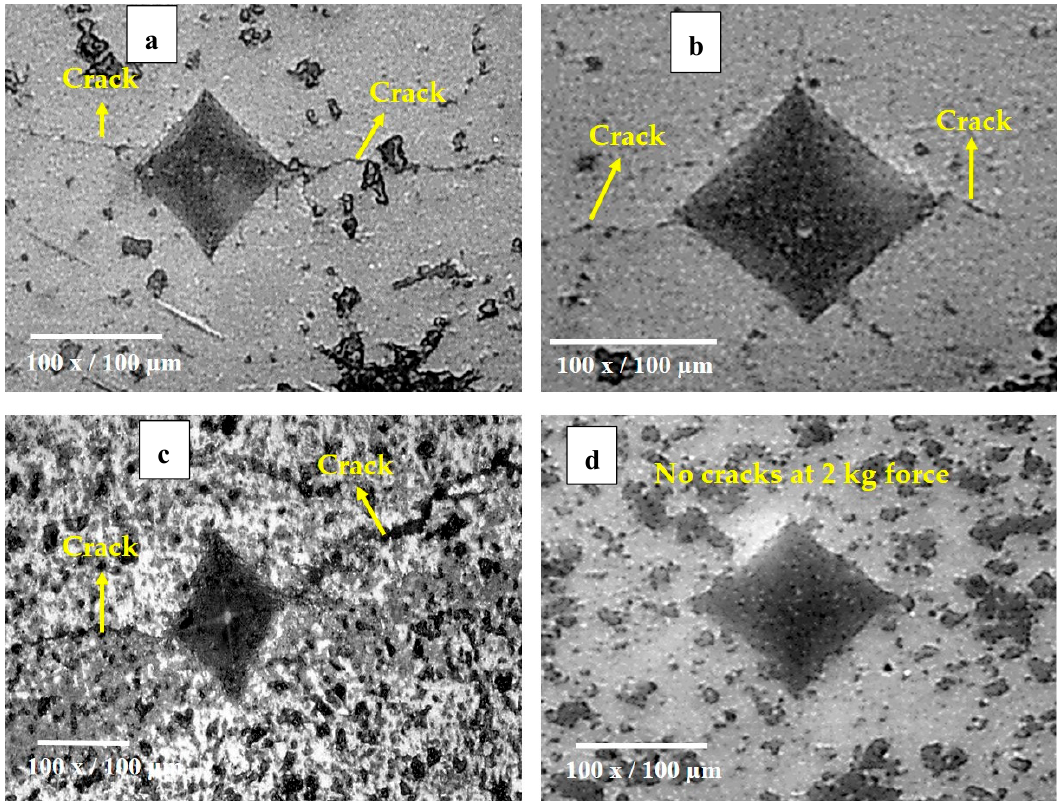
Figure 8. Optical micrographs revealing indentation crack growth in ( a ) As ( b ) AsYs ( c ) Ap and ( d ) ApYs. Table 3. Indentation crack length in the coatings.